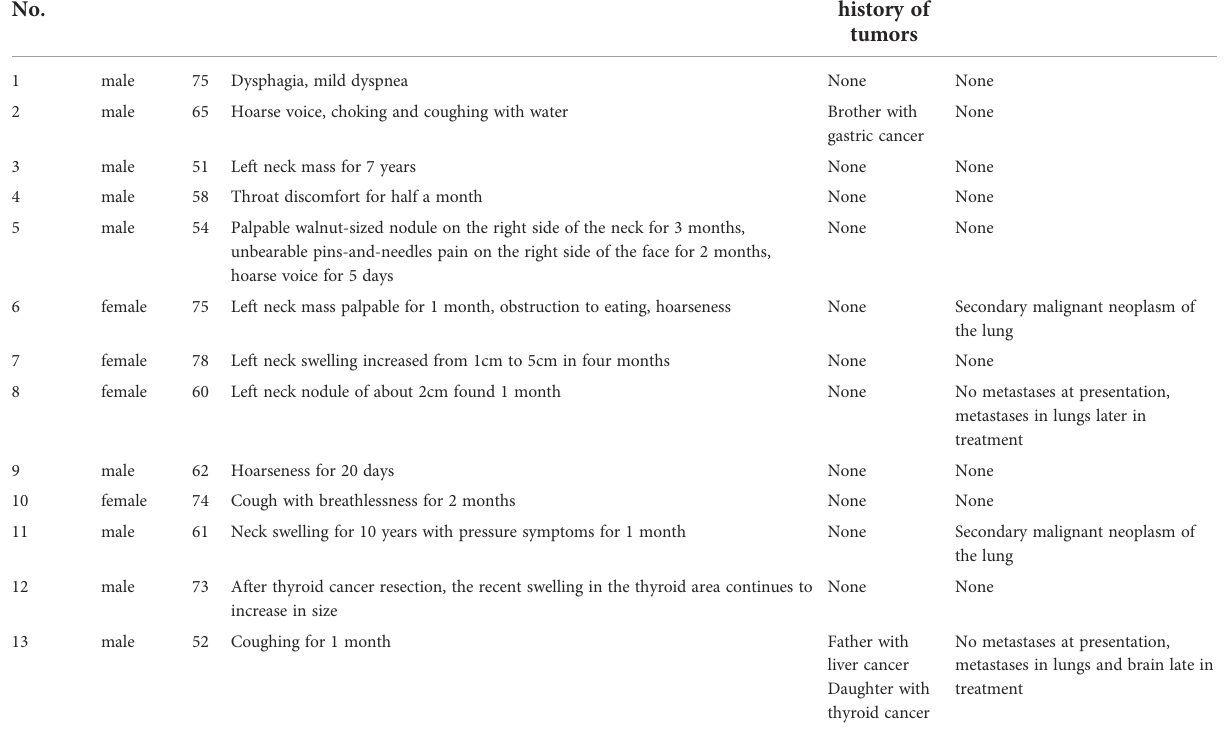
TABLE 1 Basic clinical information of 13 patients with PSCTC. Patient